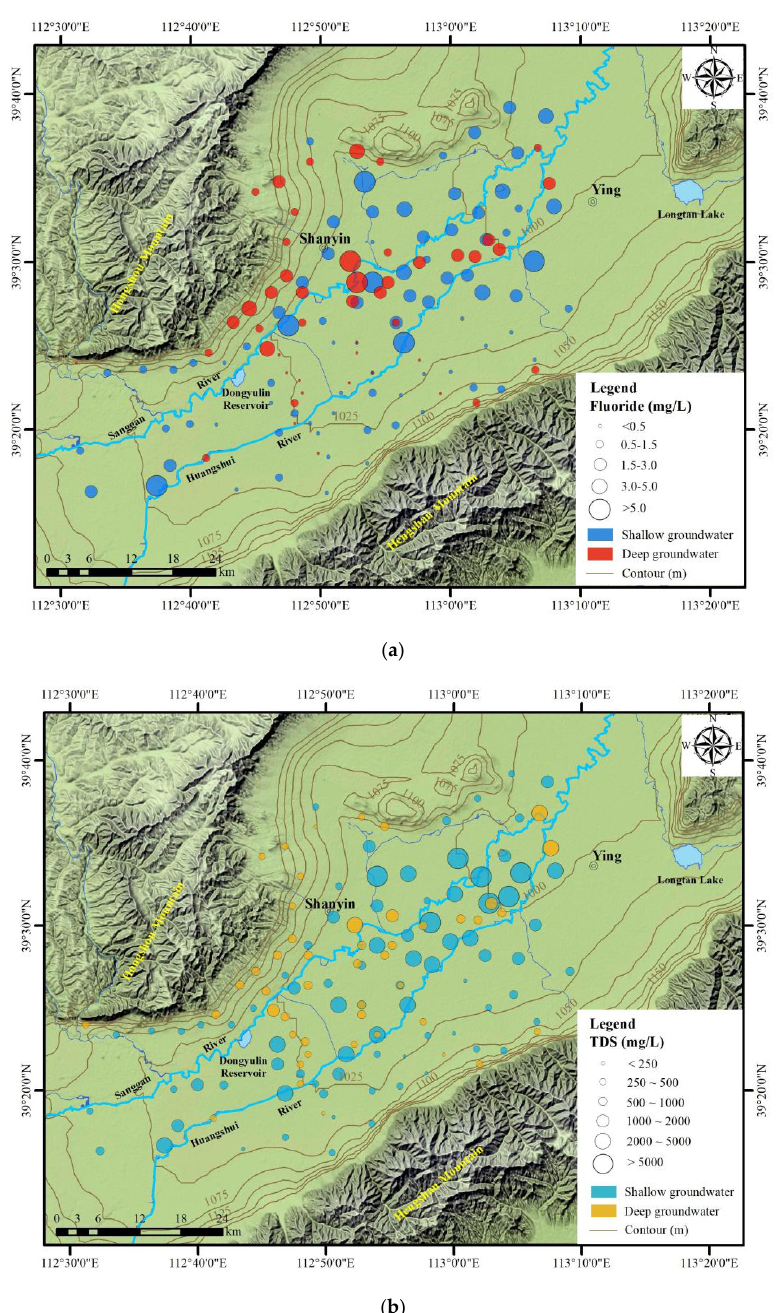
Figure 3. Horizontal distribution of groundwater ( a ) fluoride and ( b ) TDS concentrations in the study